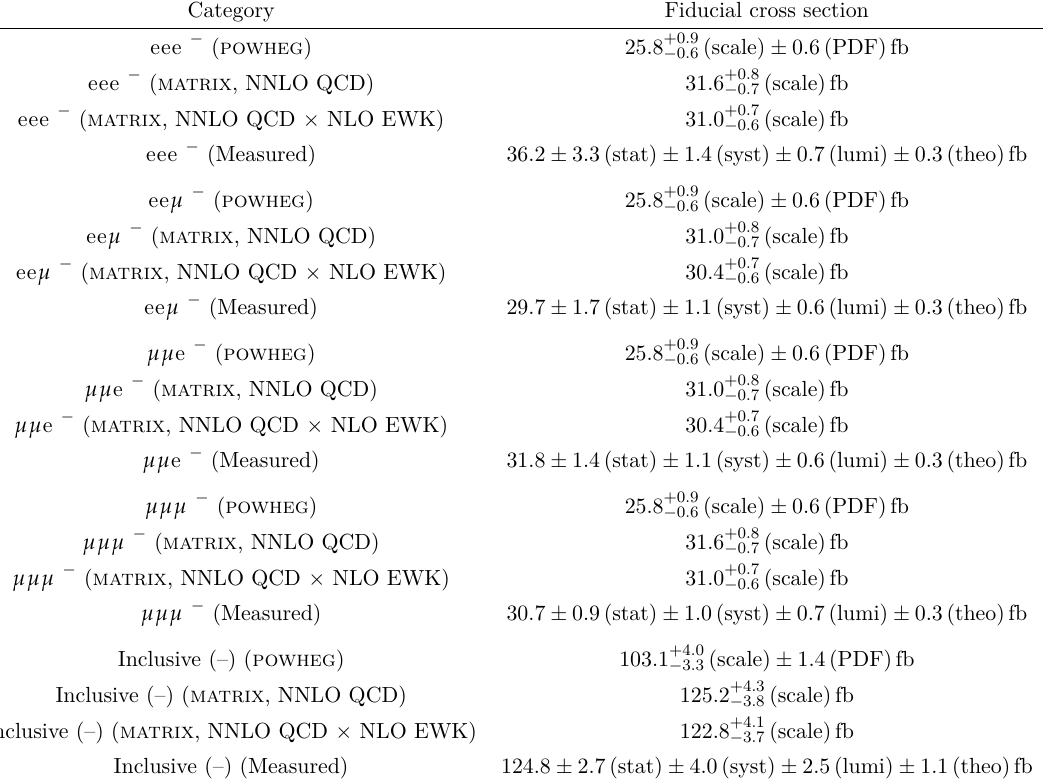
Table 9 . Measured fiducial cross sections and their corresponding uncertainties for each of the individual flavour categories, as well as for their combination, for negatively charged final states. The predictions from both matrix (at NNLO QCD and NNLO QCD × NLO EWK) and powheg (at NLO QCD) are also included.